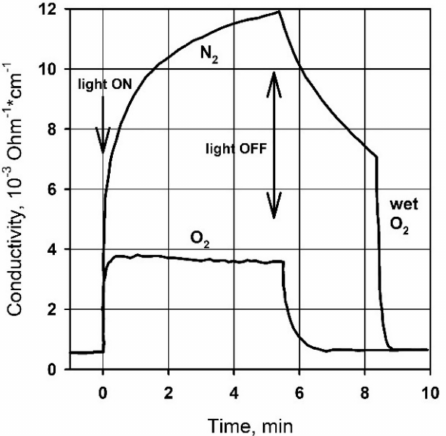
Figure 3. Kinetics of photoconductivity of single-crystal ZnO in an atmosphere of O 2 and N 2 under UV radiation. Reprinted from [16] with permission from the American Chemical Society,